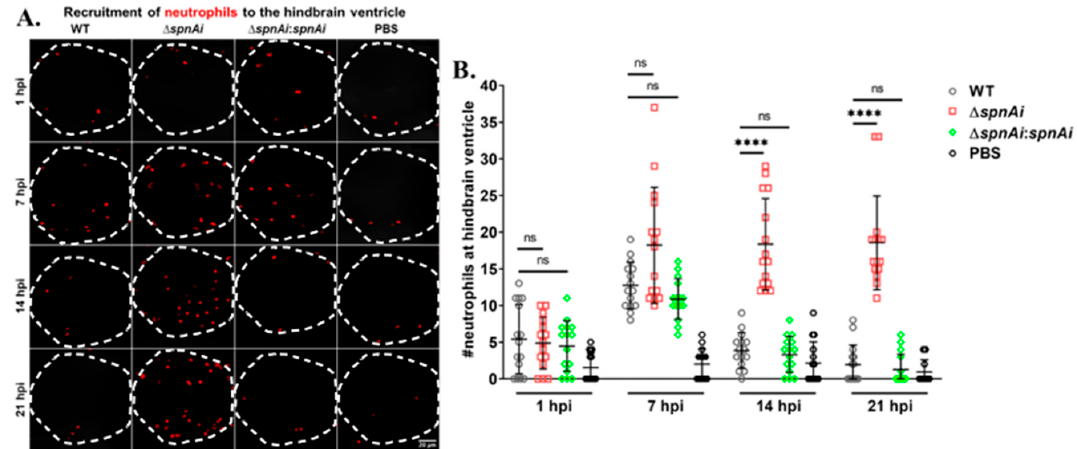
Figure 7. Quantification of neutrophils recruited at the site of S. iniae infection. (A) Immunofluorescence detection of neutrophils recruited to the hindbrain ventricle of Tg ( lyz:DsRED2 ) nz50 larvae infected with 50 CFU of WT (first column), ∆ spnAi (second column), ∆ spnAi : spnAi (third column) or sterile PBS (last column) at 1 hpi (first row), 7 hpi (second row), 14 hpi (third row) and 21 hpi (last row). The larvae ( n = 15 per group per time-point) were infected at 2 dpf and fixed at the indicated time-points. A confocal microscope was used to image immunostained neutrophils at the hindbrain ventricle of each larvae in dorsal view (white dotted line). Scale bar, 20 µ m. (B) Quantification of neutrophils in the hindbrain ventricle of individual larvae. ****, p < 0.0001; ns, not significant (as determined by a 2-way ANOVA with a Tukey’s multiple comparisons test). 3.8. Zebrafish Larvae Infected with S. iniae ∆ S5nAi Showed an Increasing Number of Macrophages at the Site of Infection Over Time